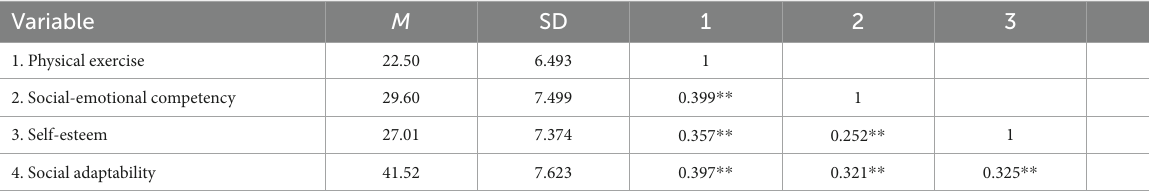
TABLE 1 Means, standard deviations, and correlations among variables.